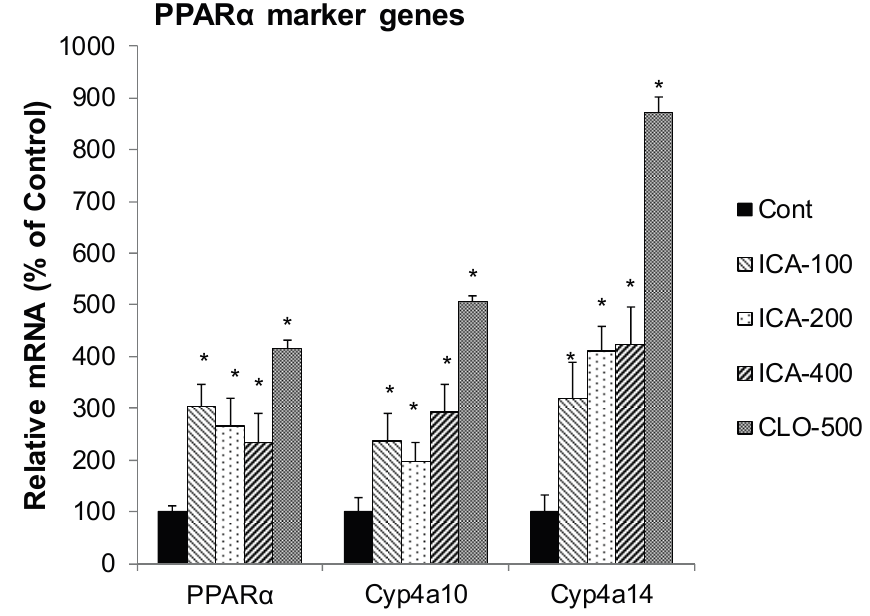
Figure 1. Effects of Icariin (ICA) on expression of PPAR α and PPAR α marker enzymes. Data are expressed as mean ± SEM (n = 5). * Significantly different from CMC-treated mice ( p <